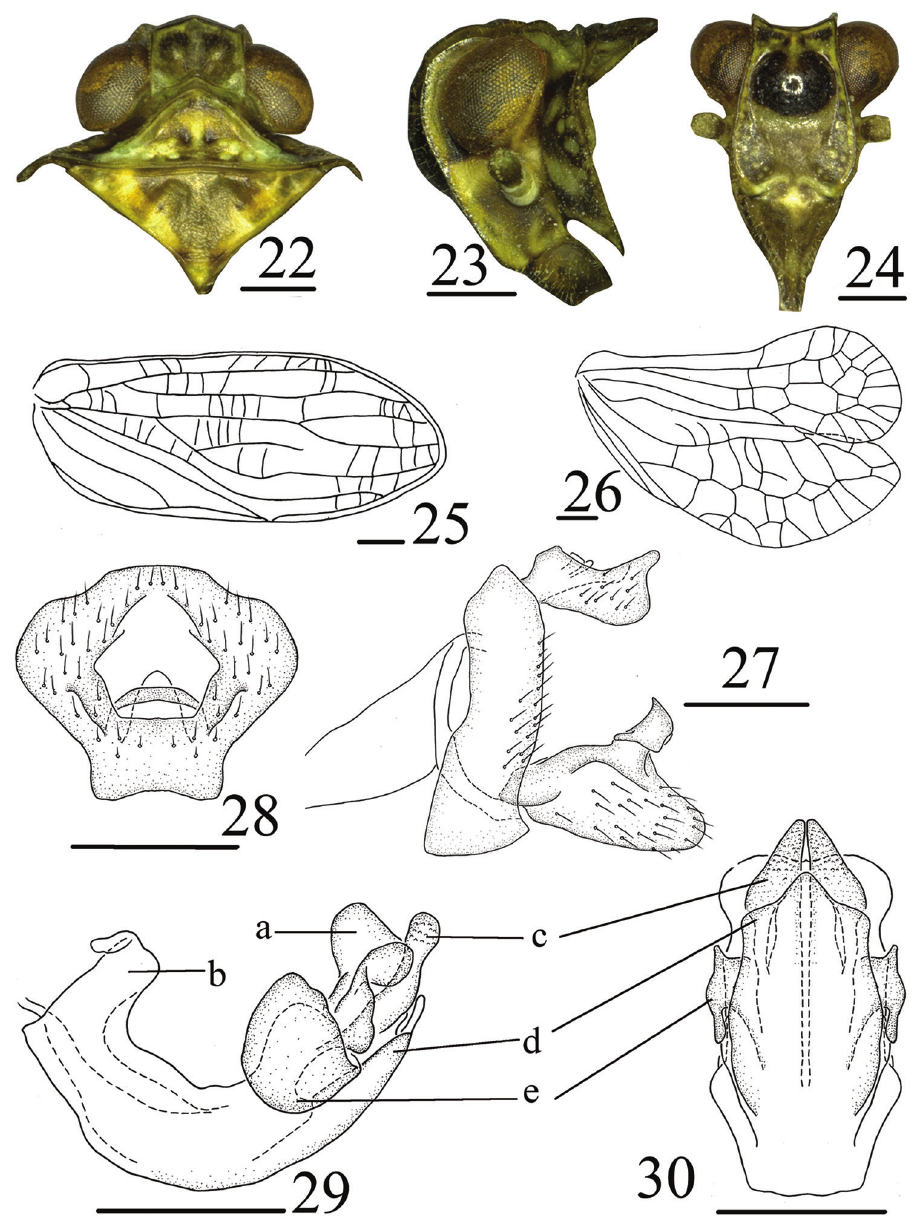
Figures 22–30. Tetricodes parvulus Chang & Chen, sp. n. 22 Head and thorax, dorsal view 23 Head and thorax, lateral view 24 Head, ventral view 25 Forewing 26 Hindwing 27 Male genitalia, lateral view 28 Anal segment, dorsal view 29 Aedeagus and phallobase, lateral view 30 Aedeagus and phallobase, ventral view. a–irregular lobes, b–long lobe-shaped process, c–lateral lobe, d–ventral lobe, e–sheet-like processes. Scale bars = 0.5